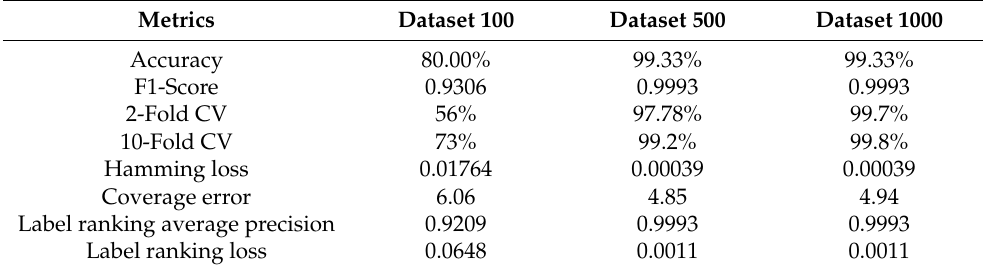
Table 2. Evaluation of